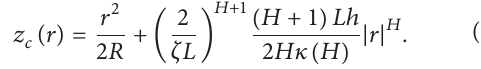
Figure 3: Normalized normal force 𝐹 𝑁 versus normal stiffness 𝑘 for a spherical indenter, superimposed with a random roughness = 9 ⋅ 10 −3 ). The red-dotted ( 𝑅 = 0.5 , 𝐻 = 0.7 , 𝐿 = 1 , ℎ rms line is the result of a 3D boundary element study. The black line is the theoretical prediction according to (16). Furthermore, the asymptotical behavior of the plain roughness (11) and the smooth Hertzian case (9) are shown. The slope of the asymptotes is 1/3 in the Hertzian case and (𝐻 + 1) −1 = 0.5882 for the roughness. The crossover occurs at 𝐹 tr /(𝐿 2 𝐸 ∗ ) = 8 × 10 −5 ; see (17).